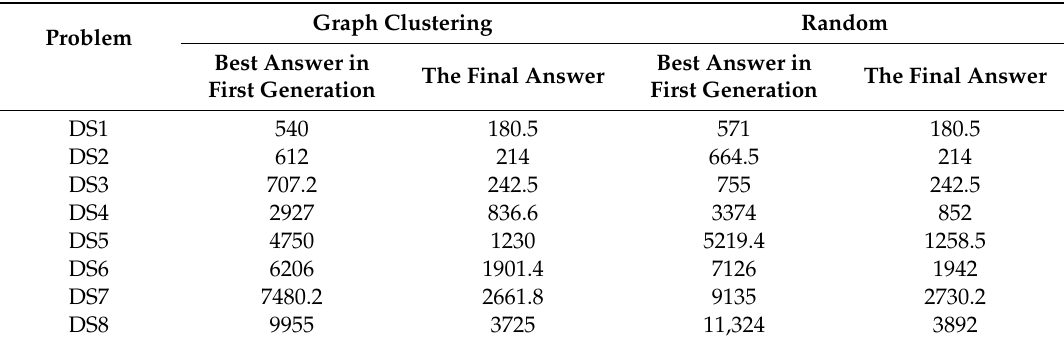
Table 13. Comparison of running algorithm in clustering and random